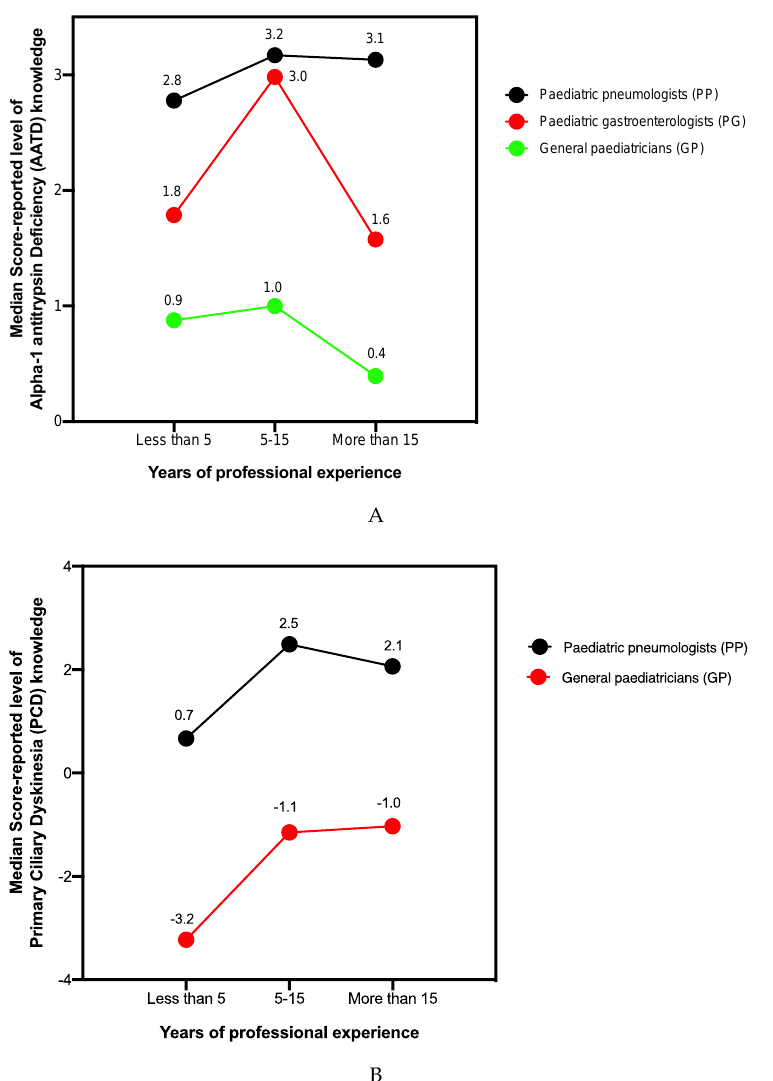
Figure 1. Alpha-1 Antitrypsin Deficiency (AATD) and Primary Ciliary Dyskinesia (PCD) knowledge in paediatric specialists in relation to years of professional experience: No group reached the minimum score required to make an early diagnosis and to adopt the appropriate measurements for correct management of patients with AATD ( A ) or PCD ( B ) regardless of years of professional experience. Maximum scores were 7 points for the AATD and 17 for the PCD tests.